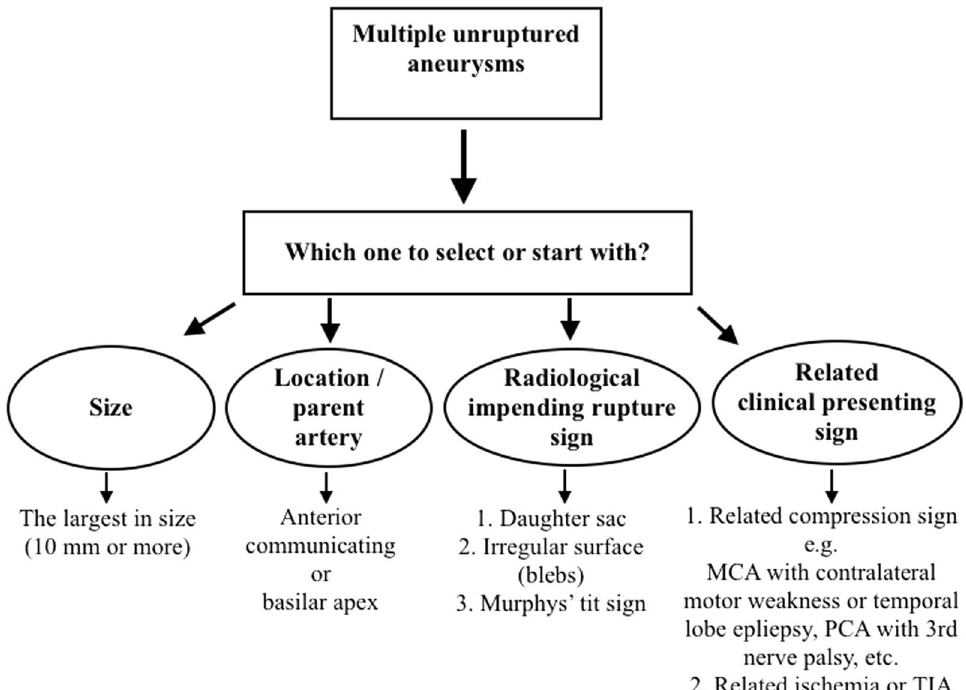
Fig. 5 Flowchart for the selection criteria for aneurysm to treat/start with in MUA